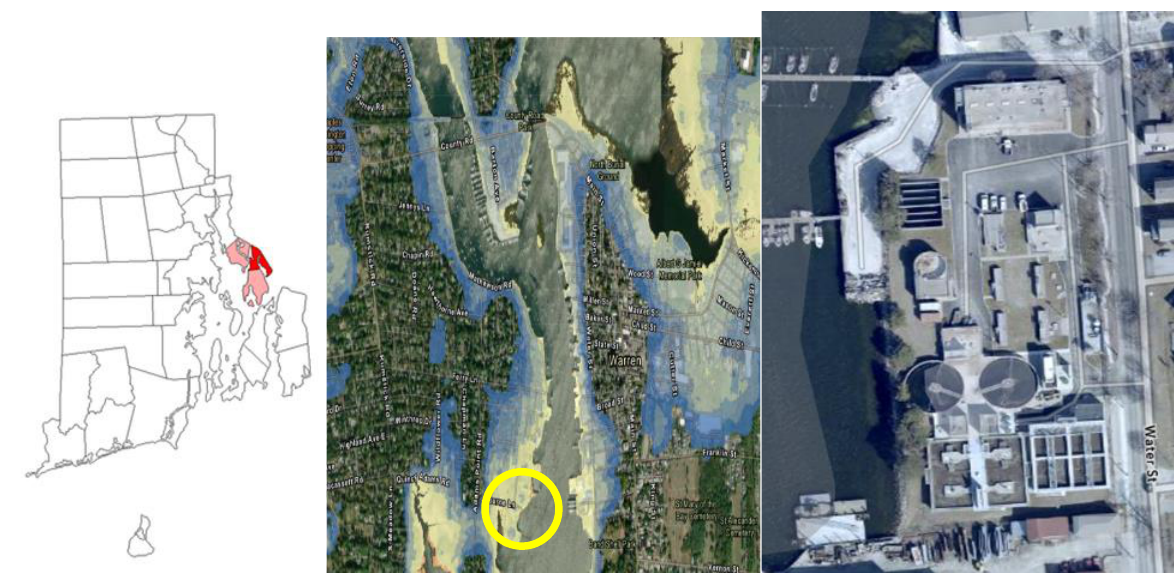
Figure 2. Location of Warren WWTF on the Warren River, RI. Location of Warren, RI in Narragansett Bay ( left panel , dark red is the Town of Warren and light red the Town of Barrington, to the north, and Town of Bristol, to the south), image of coastal flooding (100 yr) 4 to 16 ft above grade (blue to light yellow) ( center panel ) and close-up of the Warren WWTF ( right panel , see yellow circle in center panel for location) of the WWTF. (The width of the right panel is 550 ft, and the height of 750 ft). The WWTF is located at 41 43′33” N and 71 17′02” W.